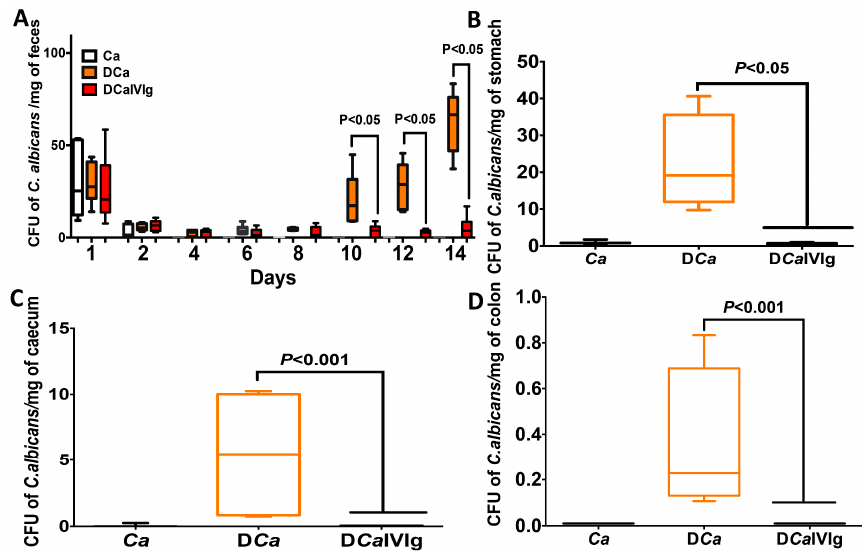
Figure 4. Evaluation of C. albicans colonization in various organs following intravenous immunoglobulin (IVIg) treatment of mice with dextran sulfate sodium (DSS)-induced colitis. ( A ) The number of C. albicans colony forming units (CFU) recovered from stools. Data are expressed as box-and-whiskers plots, with min to the max range as whiskers. ( B – D ) The number of C. albicans CFU recovered from the stomach, cecum, and colon. Data are expressed as box-and-whiskers plots, with min to the max range as whiskers.